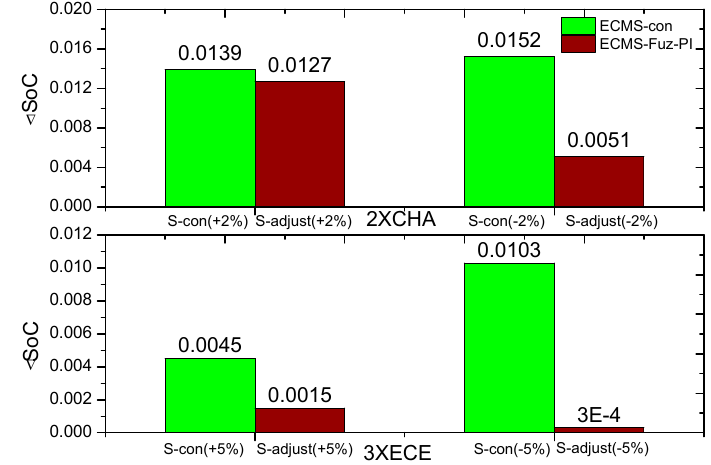
Figure 16. SoC deviation for two control strategies. Note: ECMS-con: ECMS with optimal EF; ECMS-Fuz-PI: Adaptive ECMS with a fuzzy PI controller.